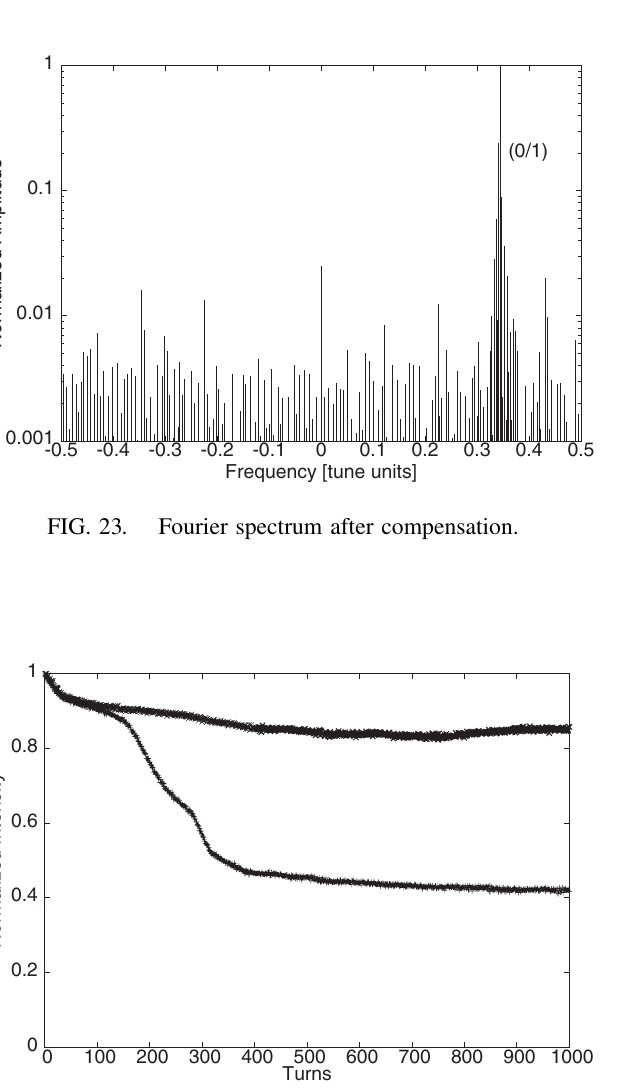
FIG. 26. Normalized vertical phase space without compensa- tion. FIG. 24. Beam Intensity before and after compensation.